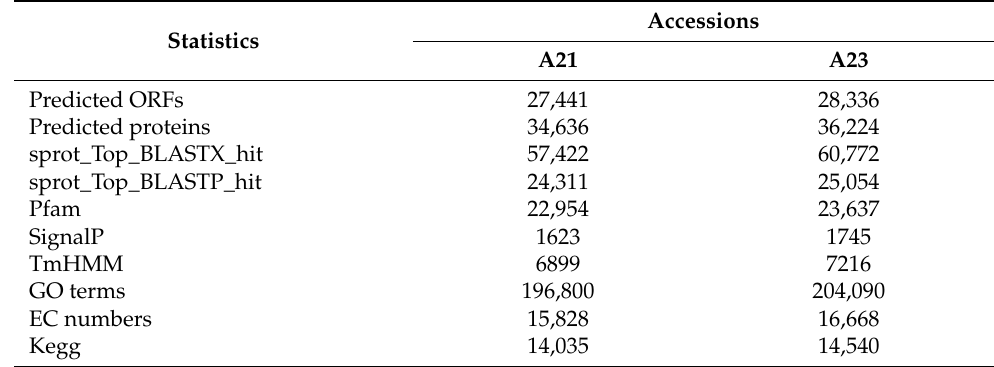
Table 2. Overview of the functional annotation by homology of transcriptomes for tree tomato accessions A21 and